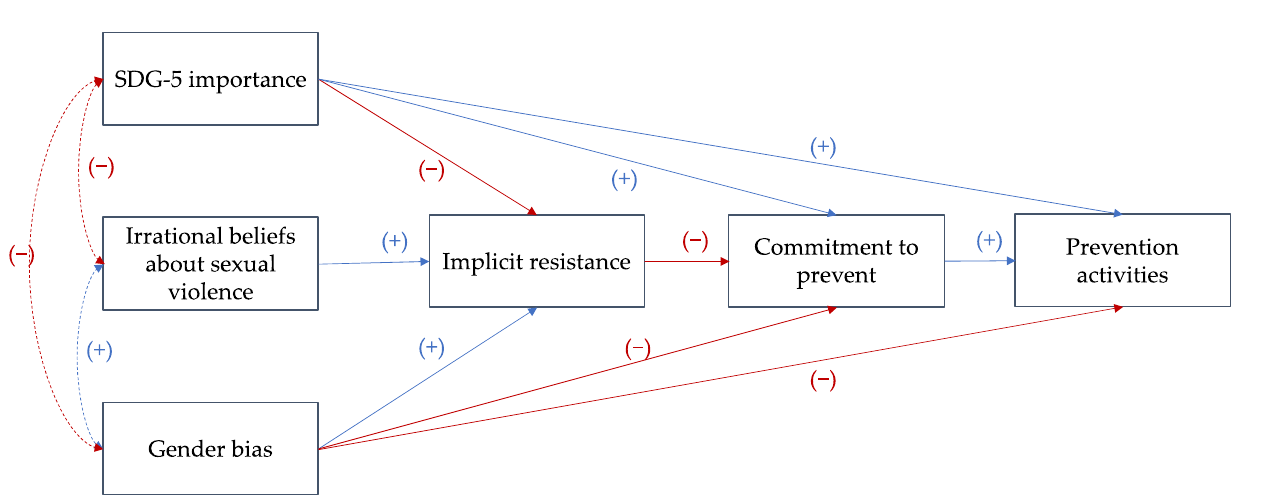
Figure 1. Conceptual model of the origin and impact of resistance implicit in managerial commitment and actions to prevent gender violence.